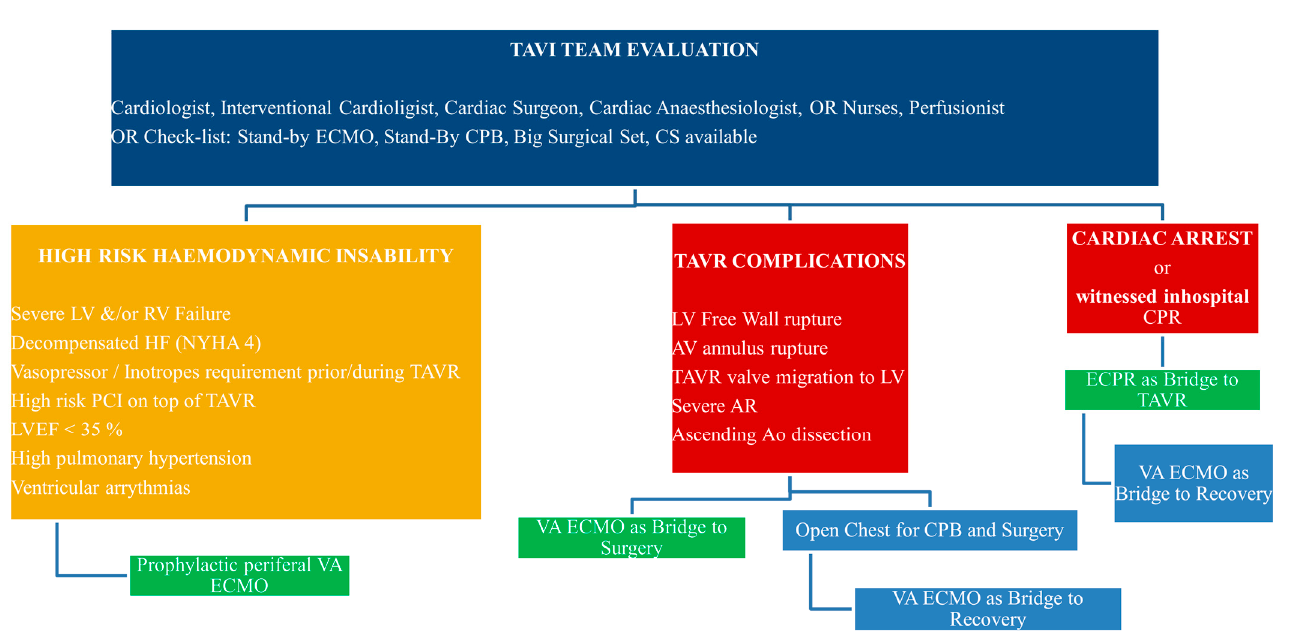
Figure 1. The algorithm of prophylactic and emergency veno-arterial extracorporeal membrane oxygenation for high-risk TAVR procedures with cardiac surgery on site. AV—Aortic Valve; CPB—Cardio Pulmonary Bypass; CS—Cardiac Surgeon; ECPR—Extracorporeal Cardio-Pulmonary Resuscitation; HF—Heart Failure; LVEF—Left Ventricular Ejection Fraction; NYHA—New-York Heart Association; OR—Operating Room; PCI—Percutaneous Intervention; RV—Right Ventricle; TAVR—Transcatheter Aortic Valve Replacement.